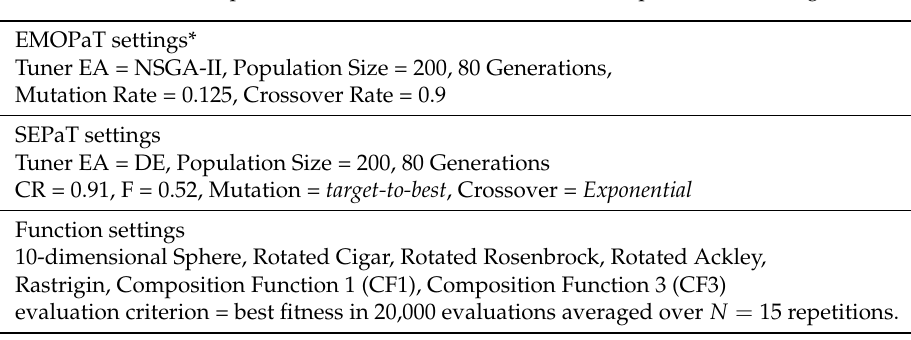
Table A1. Comparison between EMOPaT and SEPaT. Experimental